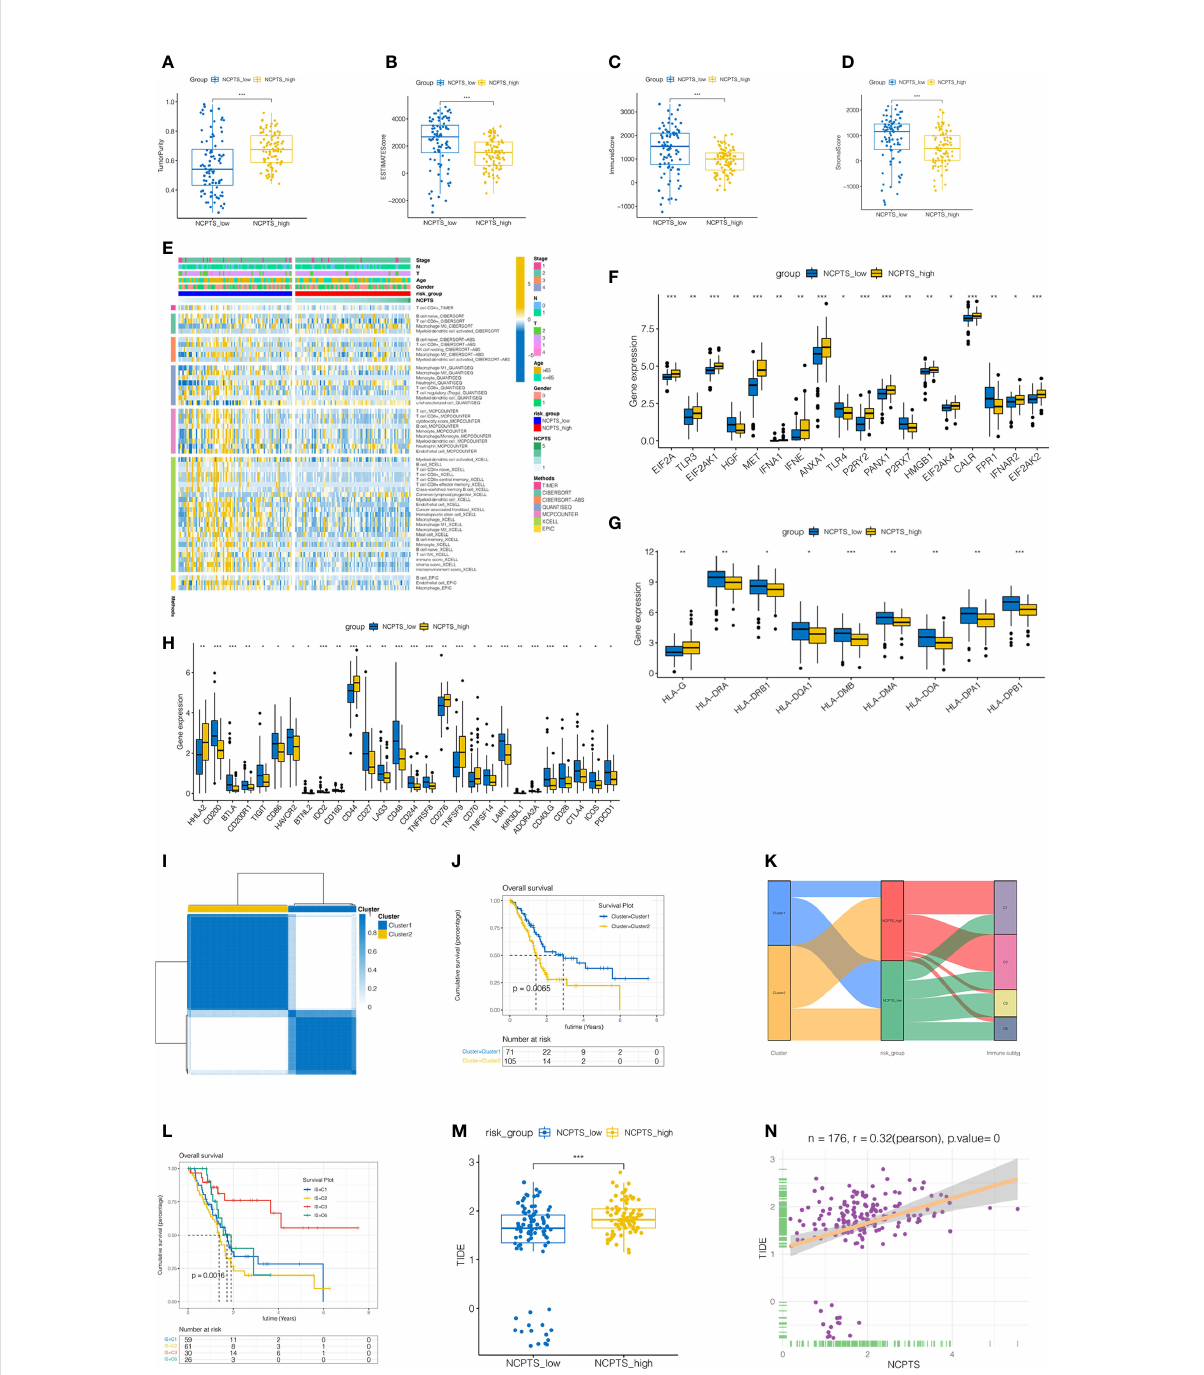
FIGURE 6 Immune in fi ltration analysis and identi fi cation of patients more suitable for immunotherapy in TCGA cohort. (A – D) Differences in immune microenvironment scores among different NCPS groups. Compared with NCPTS_high group, NCPTS_low group had higher Estimate Score, Immune Score, and Stromal Score (P<0.001), but the tumor purity was lower in the NCPTS_low group. (E) Immue landscape of different NCPS groups. (F) Differences in expression of immunogenic cell death (ICD) genes between the two groups. (G) Differences in expression of human leukocyte antigen (HLA) gene genes between the two groups. (H) Differences in expression of immune checkpoint (ICP) gene genes between the two groups. (I) Unsupervised consistency cluster analysis. Patients can be divided into two clusters according to the expression of model genes. (J) Survival analysis showed a worse prognosis for cluster2(P=0.0065). (K) Sankey diagram shows the relationship among cluster types, risk groups and immune subtypes. (L) Survival analysis of different immune subtypes. (M) TIDE scores in different NCPS risk groups. TIDE scores in different NCPS risk groups. TIDE score was higher in NCPS_high group. ***P<0.001 (N) Pearson correlation analysis showed a positive correlation between NCPTS and TIDE. *P<0.05;